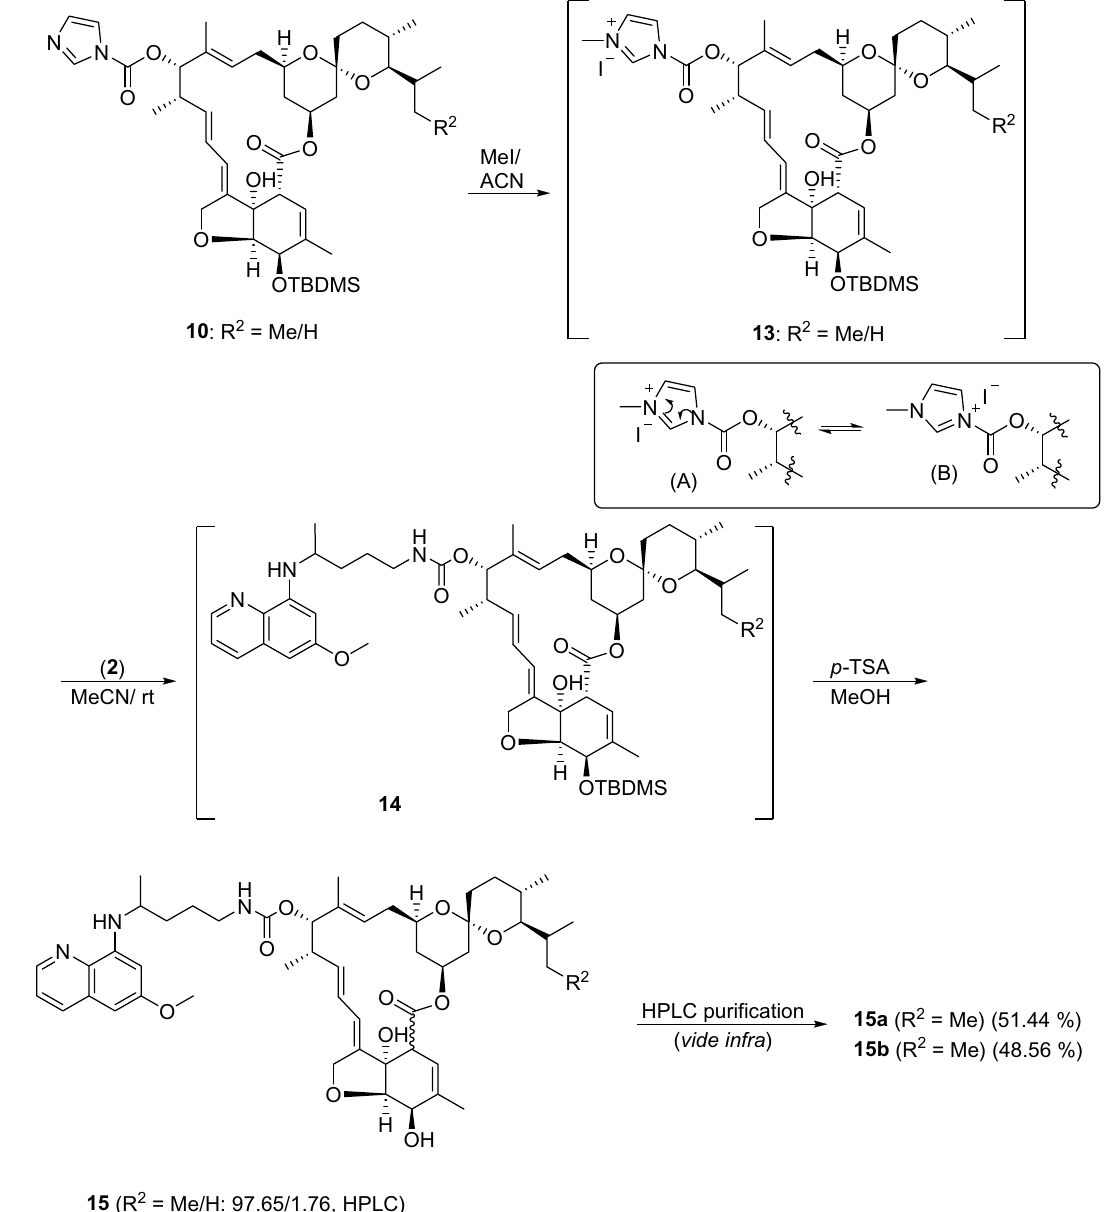
Figure 4. Synthesis of IVM-PQ conjugates 15 from intermediate 10 derived from 8